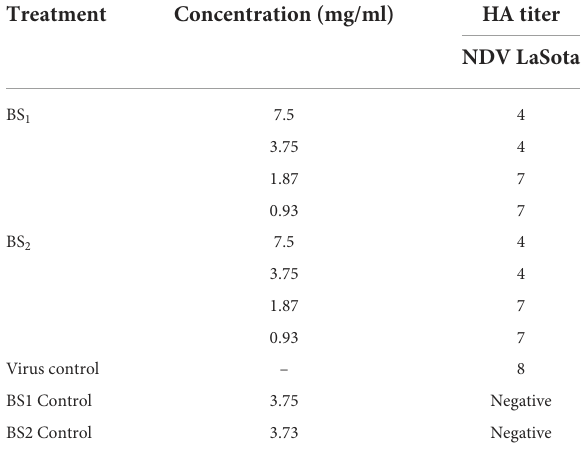
TABLE 5 Haemagglutination activity of NDV LaSota, vNDV, Influenza H 9 N 2 strains treated by BS 1 and BS 2 solutions in embryonated chicken